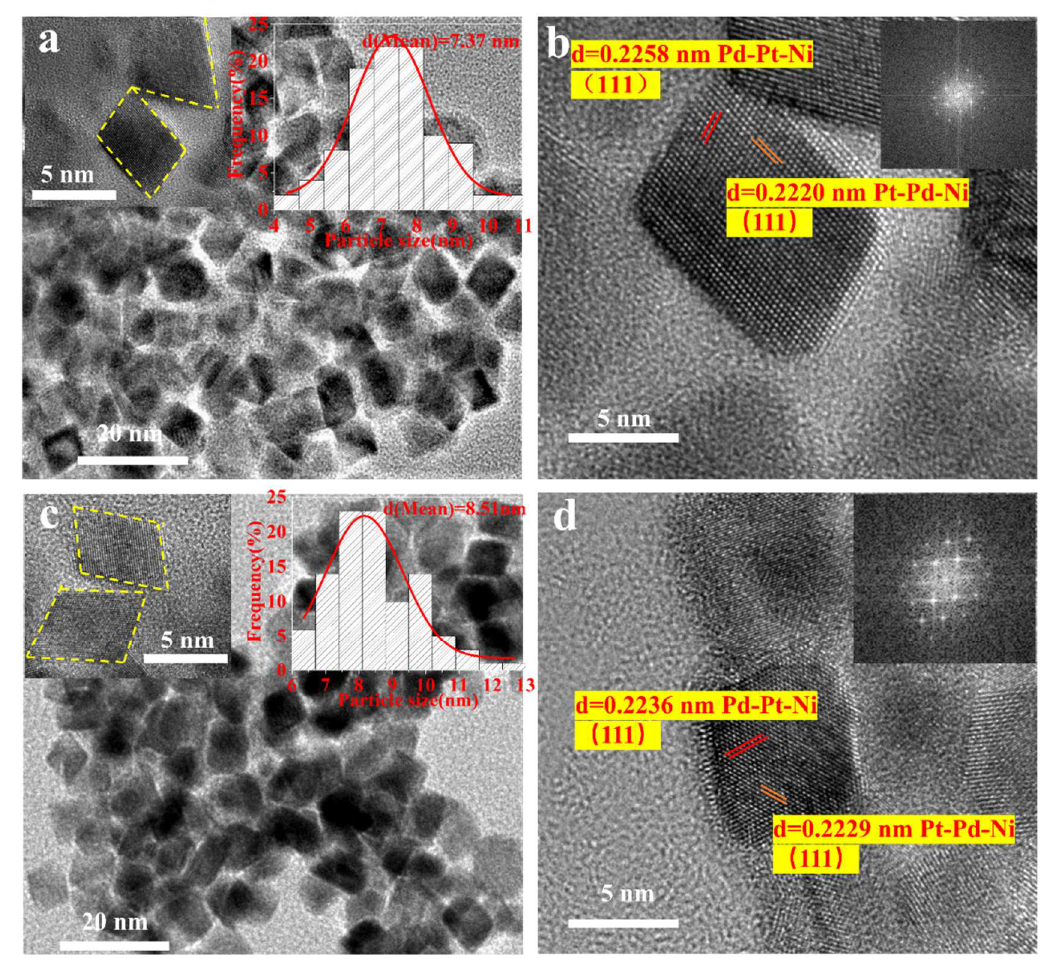
Figure 4. ( a – d ) TEM images of Pd-Pt-Ni octahedra2 (Pd-Pt-Ni Octa2) and Pd-Pt-Ni octahedra3 (Pd-Pt-Ni Octa3) obtained using various feeding ratios of Pt-Ni: ( a ) TEM images of Pd-Pt-Ni Octa2 and feeding ratios of Pt-Ni of 1:1; ( b ) HRTEM images of a single Pd-Pt-Ni Octa2 and calibration of the atomic spacing and lattice constants; ( c ) TEM images of Pd-Pt-Ni Octa3 and feeding ratios of Pt-Ni of 2:1; ( d ) HRTEM images of Pd-Pt-Ni Octa3 and calibration of the atomic spacing and lattice con- stants.